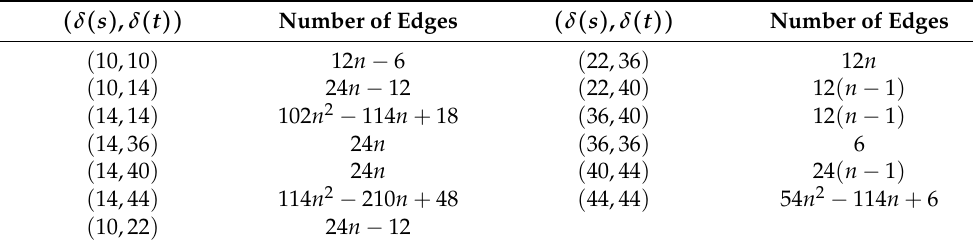
Table 4. Edge partition based on sum of degrees for BDPOH ( n )